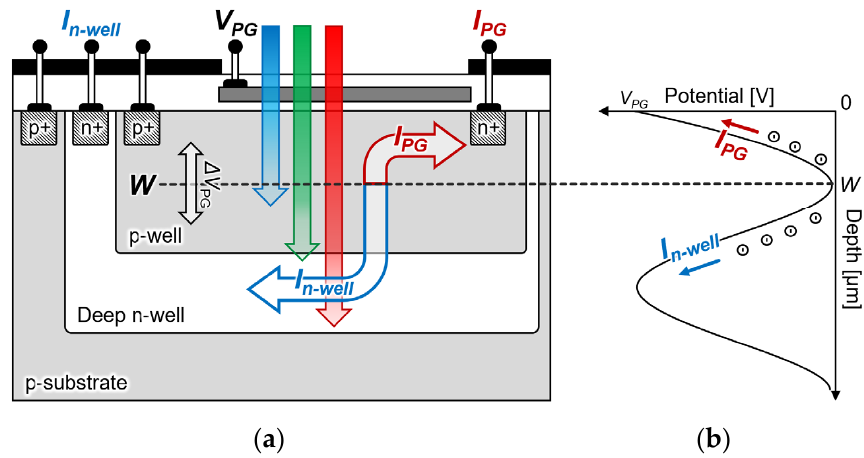
Figure 2. Proposed filter-free wavelength sensor: ( a ) cross-sectional schematic; ( b ) potential distribution. The light intensity φ 0 on the silicon surface was calculated by substituting the mea- sured